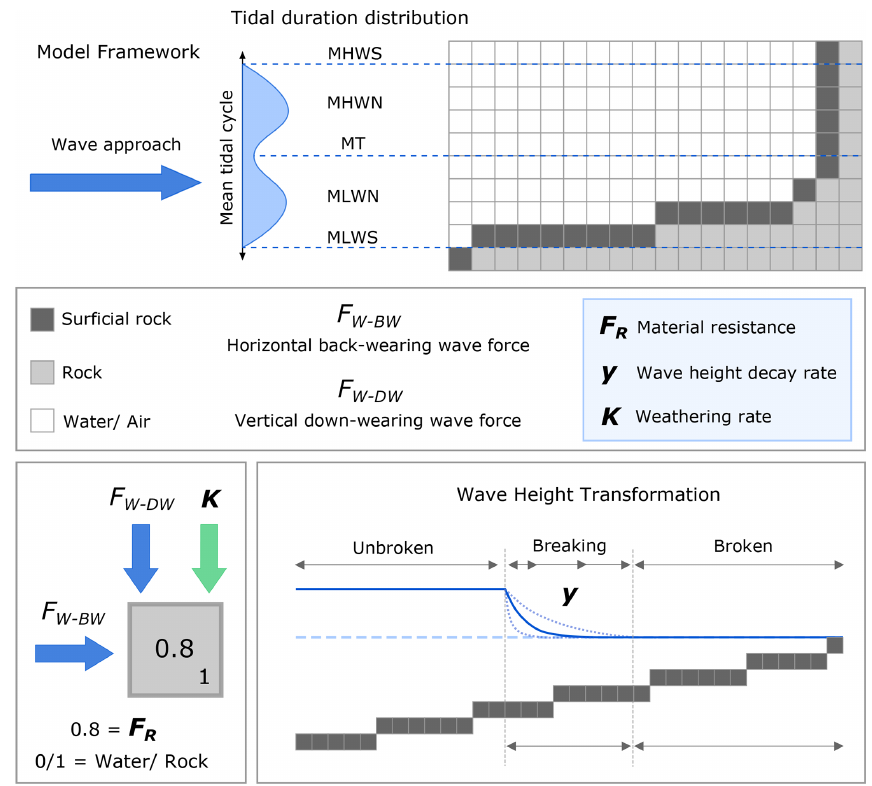
Figure 3. Coastal evolution model schematic. Topographic profile cross section constructed in a gridded framework, showing wave approach and influence of tidal duration distribution. MHWS, MHWN, MT, MLWN, and MLWS denote mean high water spring, mean high water neap, mid tide, mean low water neap, and mean low water spring. Binary values of 0 and 1 are assigned to water–air and rock categorised cells, respectively. Rock cells (value 1) are eroded and removed from the profile (assigned value 0) once wave force exceeds material resistance ( F W ≥ F R ) (b, c) . Subaerial weathering ( K ) can also lower the material resistance value ( F R ). Wave height decay rate ( y ) controls the distance waves can break across the shore platform and, as a result, the erosional potential of wave assailing force F W